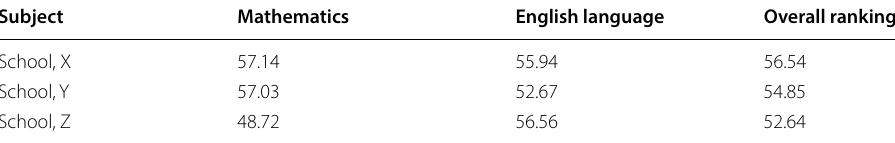
Table 6: 3-Year average